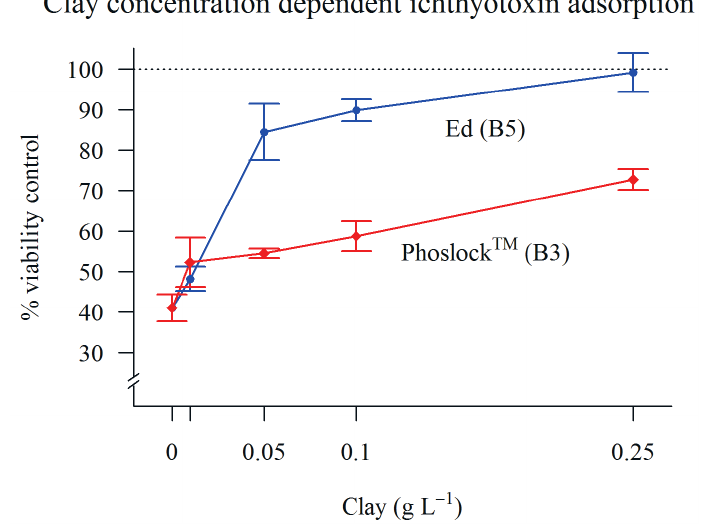
Figure 7. Gill cell viability after exposure to lysed P. parvum preparations treated with different concentrations (0–0.25 g L − 1 ) of Ed clay (blue circles) and lanthanum-modified bentonite (Phoslock™; red diamonds) at pH